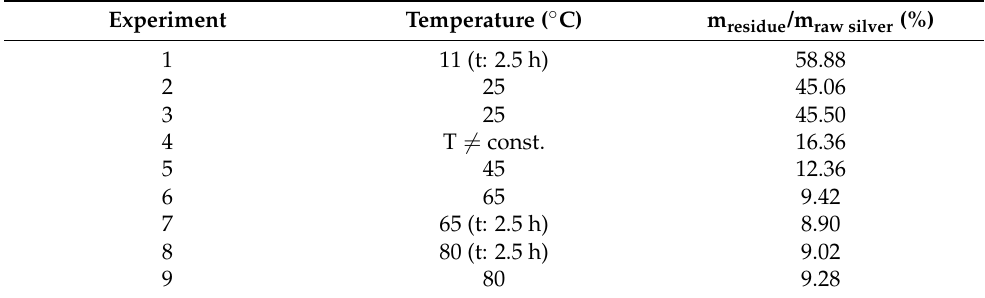
Table 3. Mass ratio of leaching residues and raw silver granules for leaching at different temperatures; solid conc.: 50 g/0.1 L.